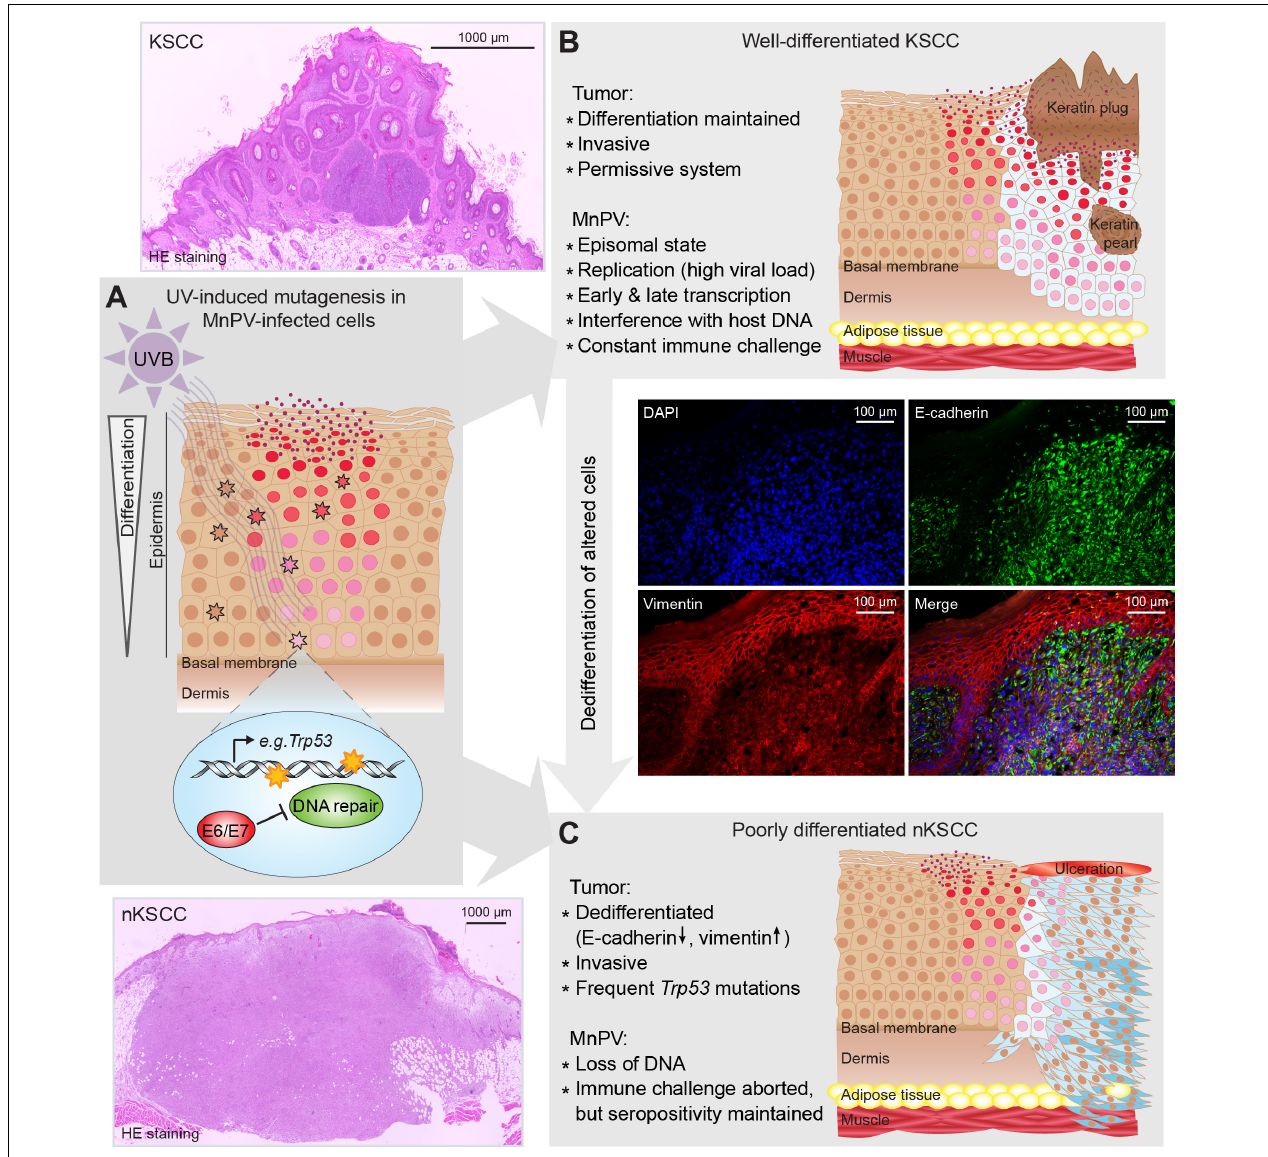
FIGURE 2 | Suggested “hit-and-run” model based on experiments with Mastomys coucha . (A) Virus replication and virion formation depend on differentiating squamous cells and are favored by UV-induced hyperproliferation. UV induces photoproducts, e.g., in Trp53 . In uninfected cells, damages are repaired. In infected cells, MnPV reduces chromosomal stability and inhibits DNA repair leading to an accumulation of mutations. (B) Altered squamous cells become neoplastic (light blue) and start forming a well-differentiated keratinizing SCC, still representing a permissive system that allows viral replication and formation of virions. (C) When neoplastic squamous cells accumulate further mutations (dark blue), a dedifferentiated phenotype (characterized by a switch from E-cadherin to vimentin expression) is acquired, forming a poorly differentiated, non-keratinizing SCC (nKSCC). MnPV cannot replicate in this intracellular environment, resulting in a loss of viral DNA. (Scheme modified from Hasche et al.,